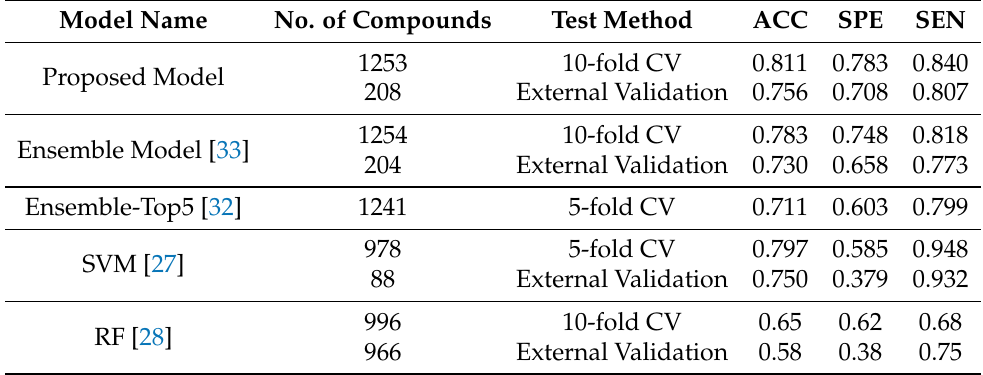
Table 5. Proposed model performance compared with the previously published